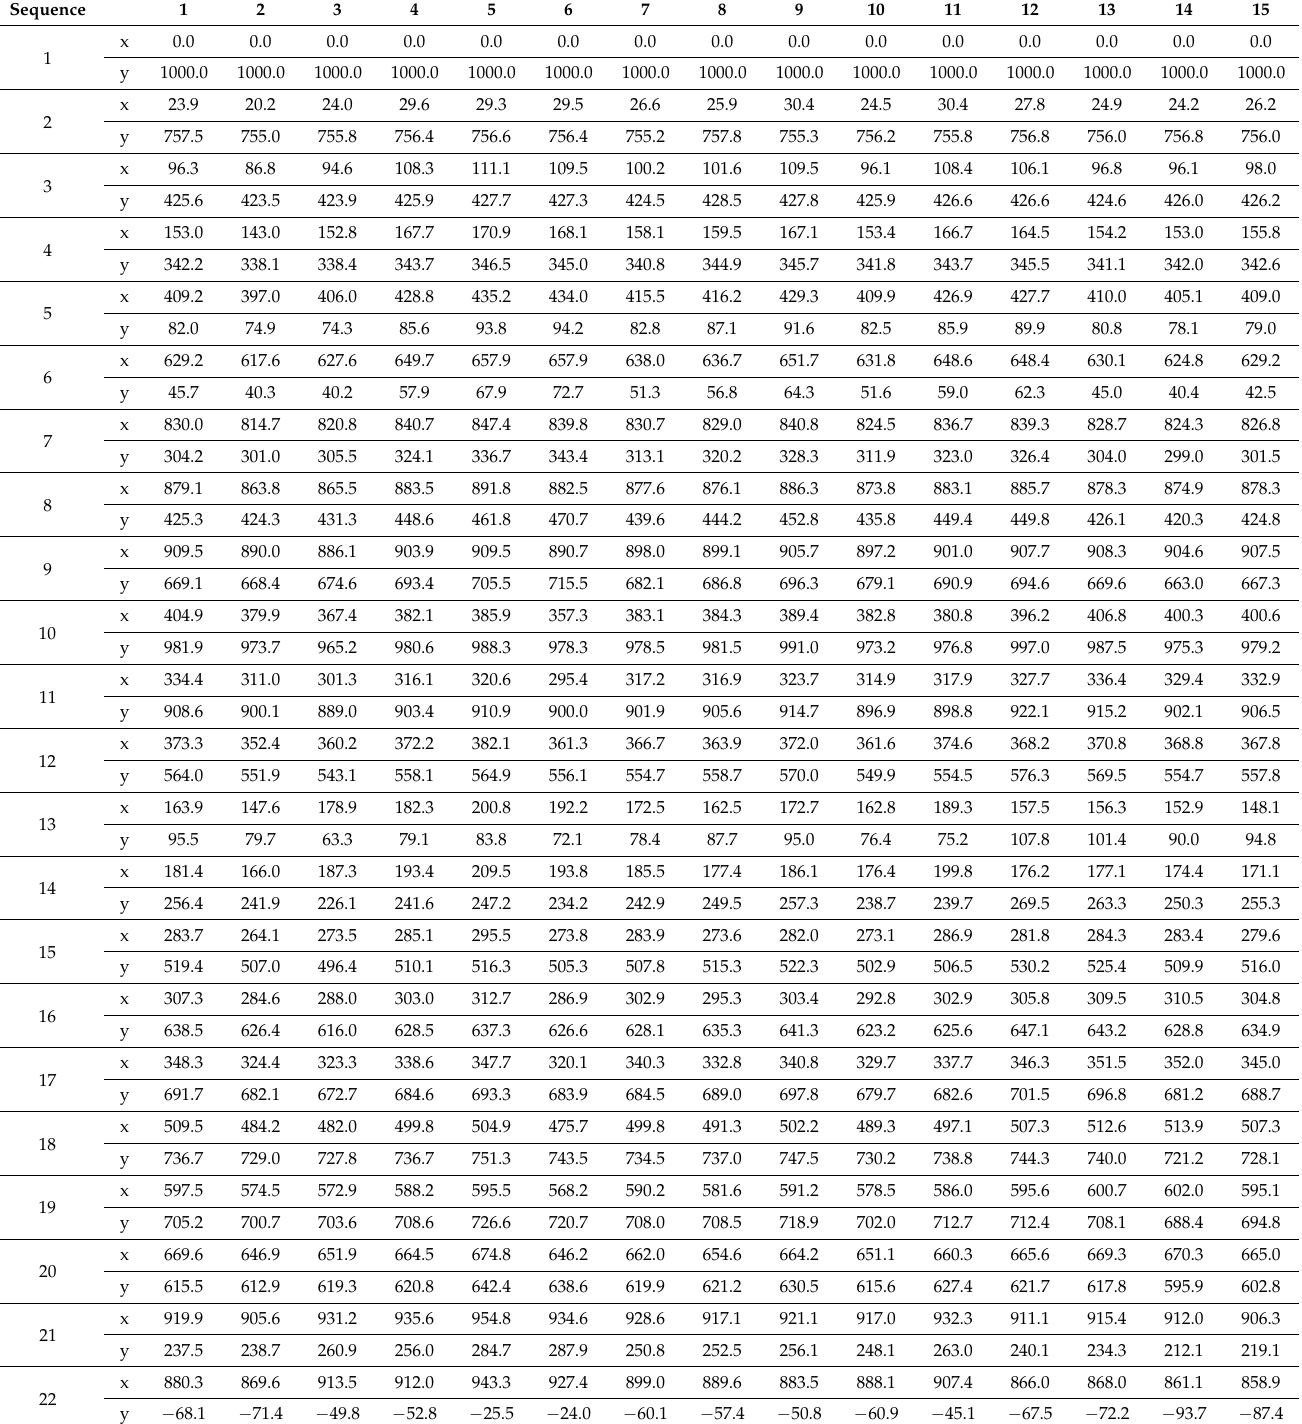
Table A6. Experiment data when moving along the path with the least rotation. The movement commands have not been compensated